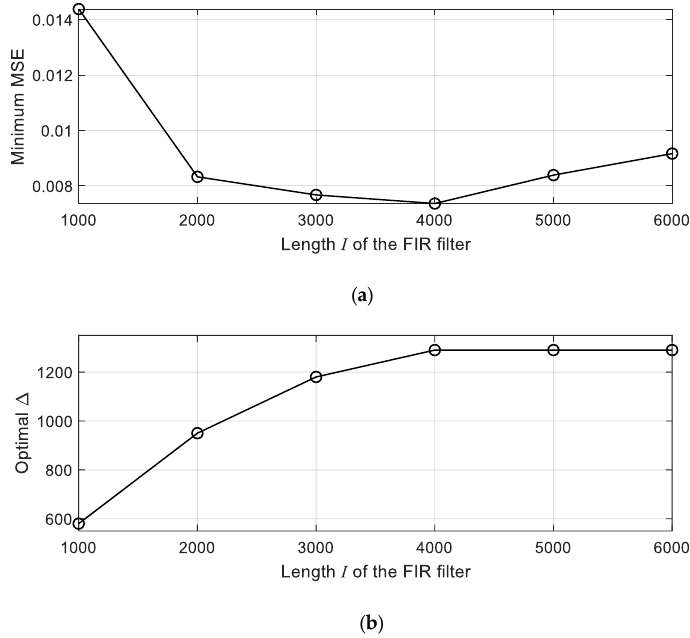
Figure 9. ( a ) Minimum MSE with ( b ) the optimal ∆ at each length I of the FIR filter.